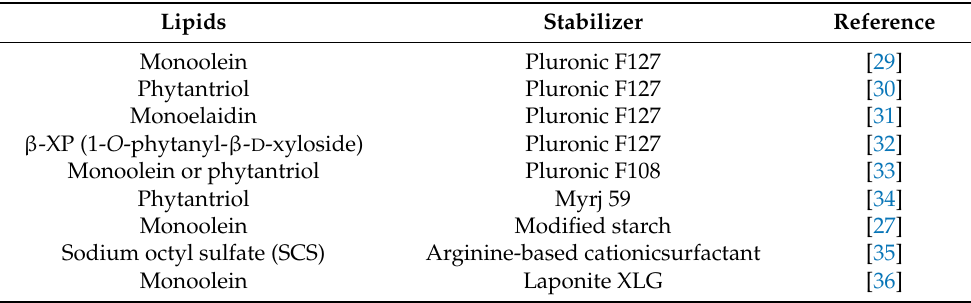
Table 1. Stabilizing agents and lipids used in preparation of cubosomes. Lipids Stabilizer Reference